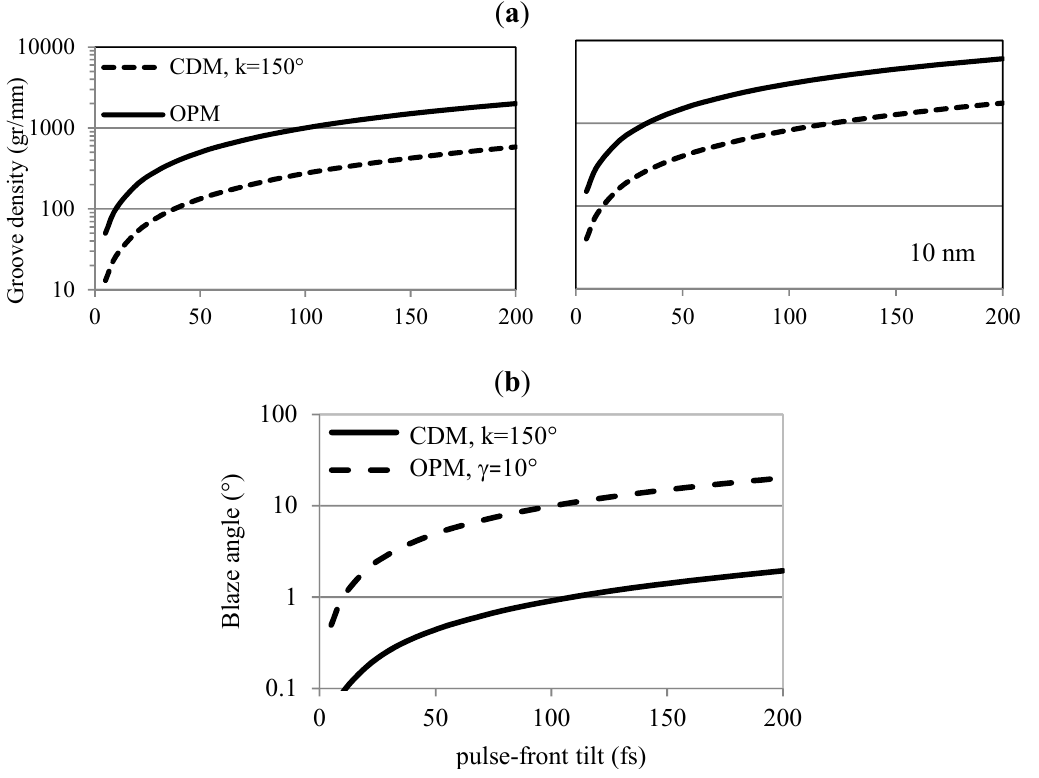
Figure 5. Grating parameters as a function of the pulse-front tilt for 1-mm half-width beam section: ( a ) groove density at 30 nm ( left ) and 10 nm ( right ); ( b ) blaze